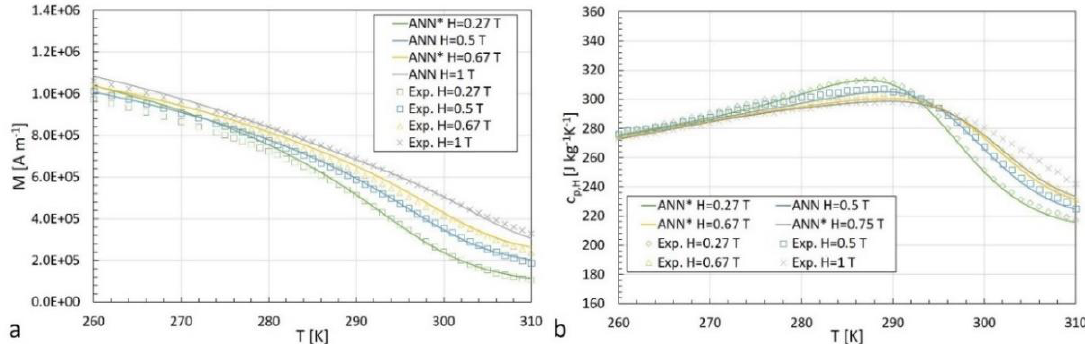
Figure 3. Measured and predicted value at different magnetic fields: ( a ) Magnetization of Gadolinium, ( b ) Specific heat at a constant magnetic field of Gadolinium. The asterisk in the legend indicates an applied magnetic field not included in the training dataset.